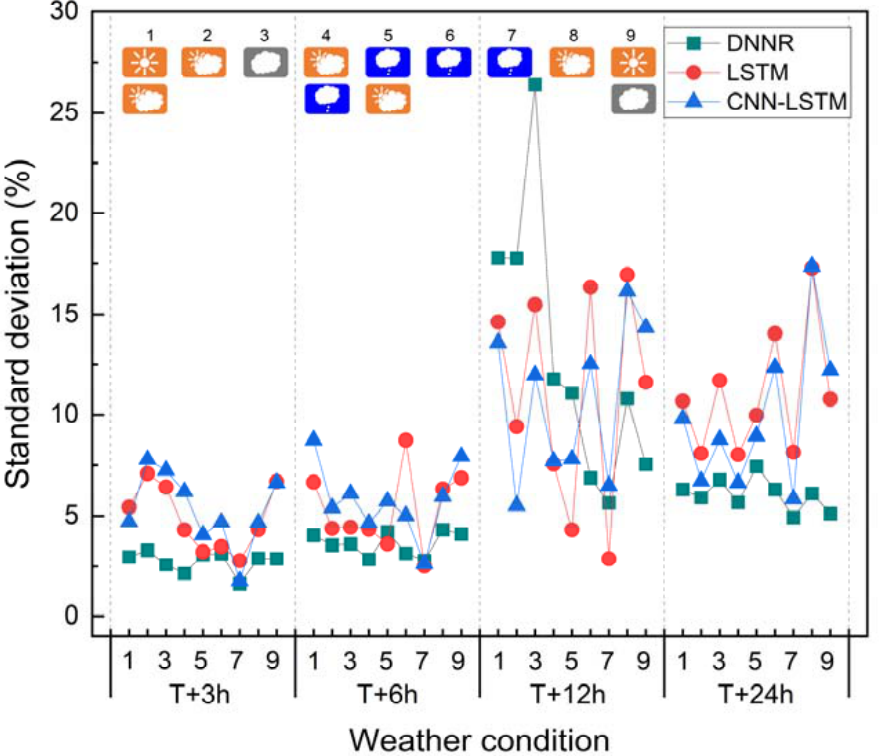
Figure 13. Statistics of the error distribution between the predicted value of the best model and the actual value for the humidity of Greenhouse A.